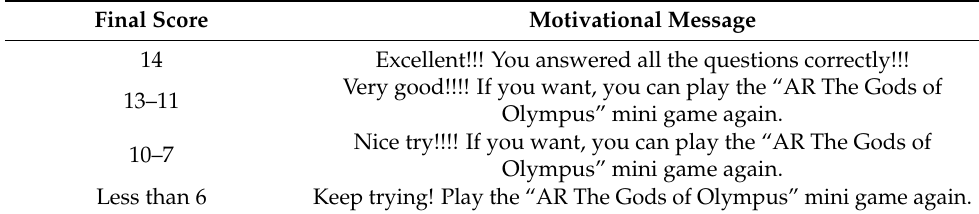
Figure 9. Wrong answer in the “Quiz game”. Table 3. Motivational messages in the “Quiz